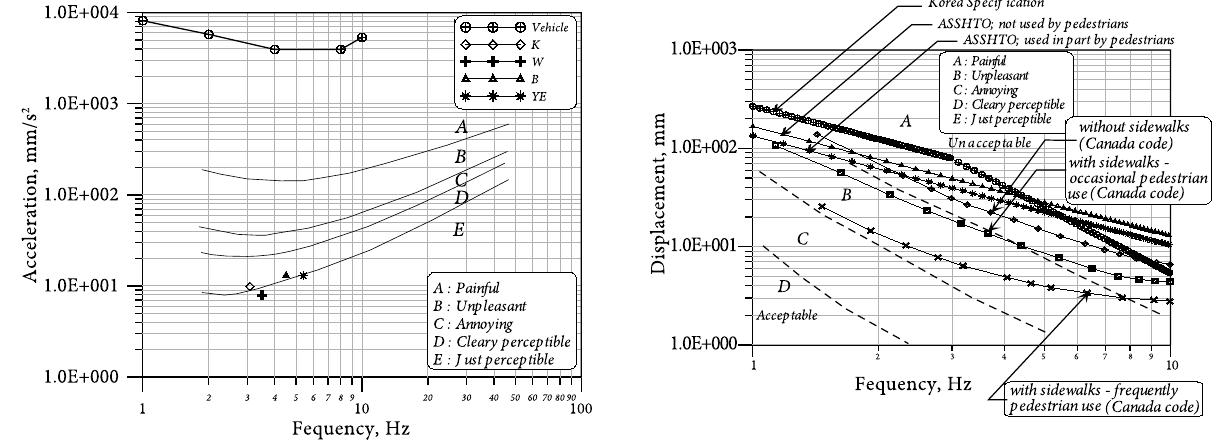
Fig. 2. Comparison between Reiher-Meister and ISO 2631